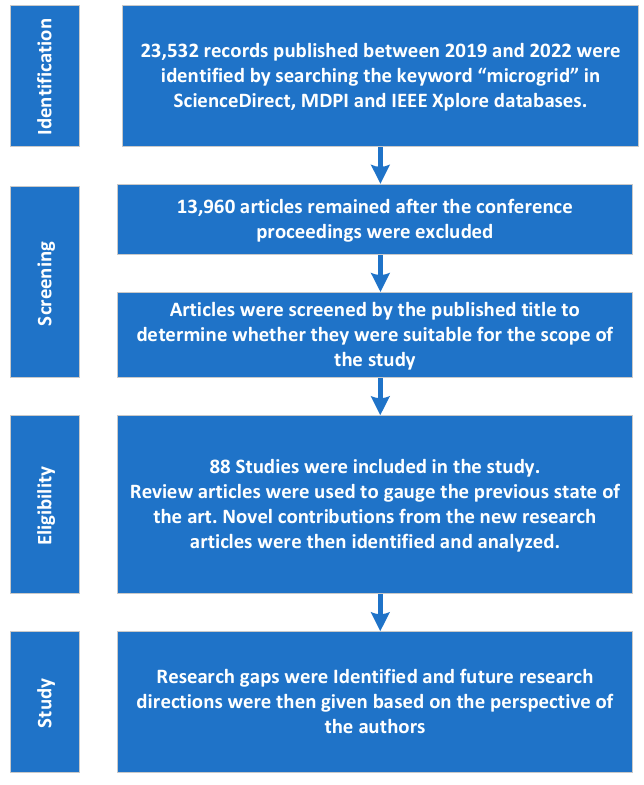
Figure 1. Methodology adopted in this review article.